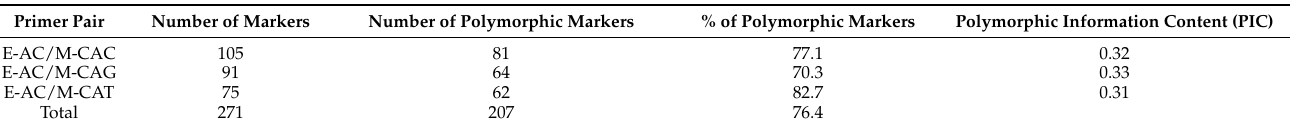
Table 2. Number of markers and polymorphic markers, percentage of polymorphic markers, and polymorphic information content